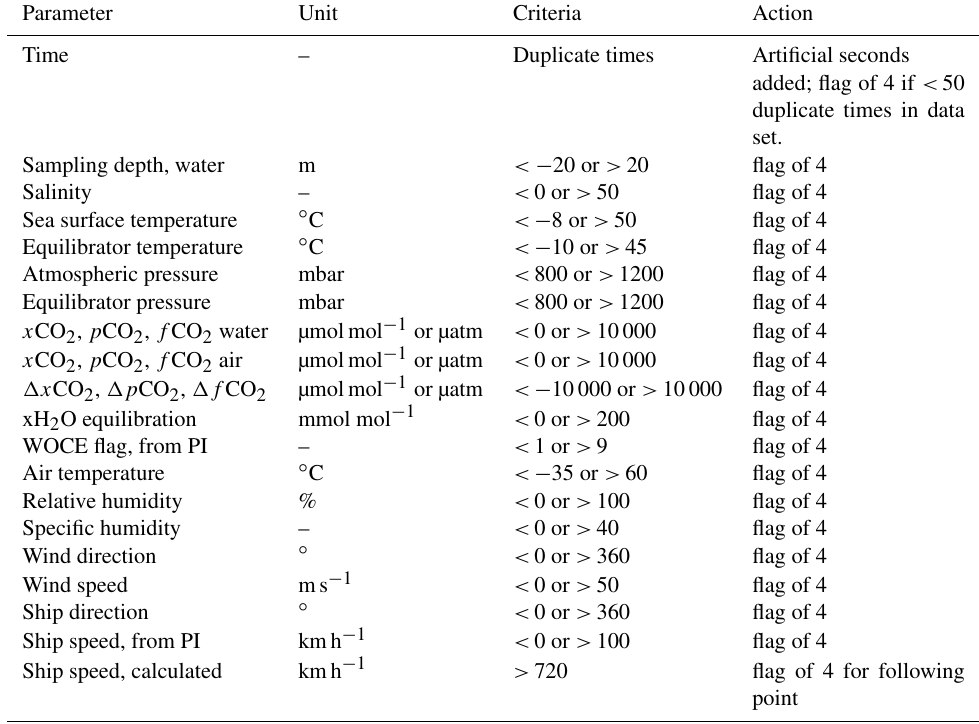
Table 7. Criteria for the automated data checks and the action taken in version 3. In the case of duplicate time stamps, artificial seconds were generated. If there were less than 50 duplicate times in the data set, a WOCE flag of 4 was given. For other parameters, a flag of 4 was automatically assigned to the f CO 2 rec value if their values were outside a specified range. Criteria not directly affecting f CO 2 rec values will be revised for version 4 (Sect.